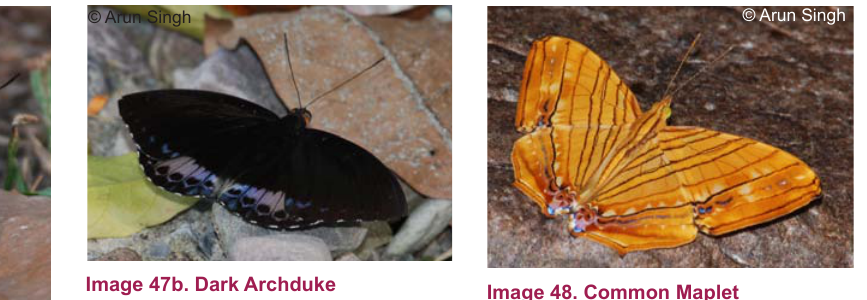
Image 48. Common Maplet Chersonesia risa